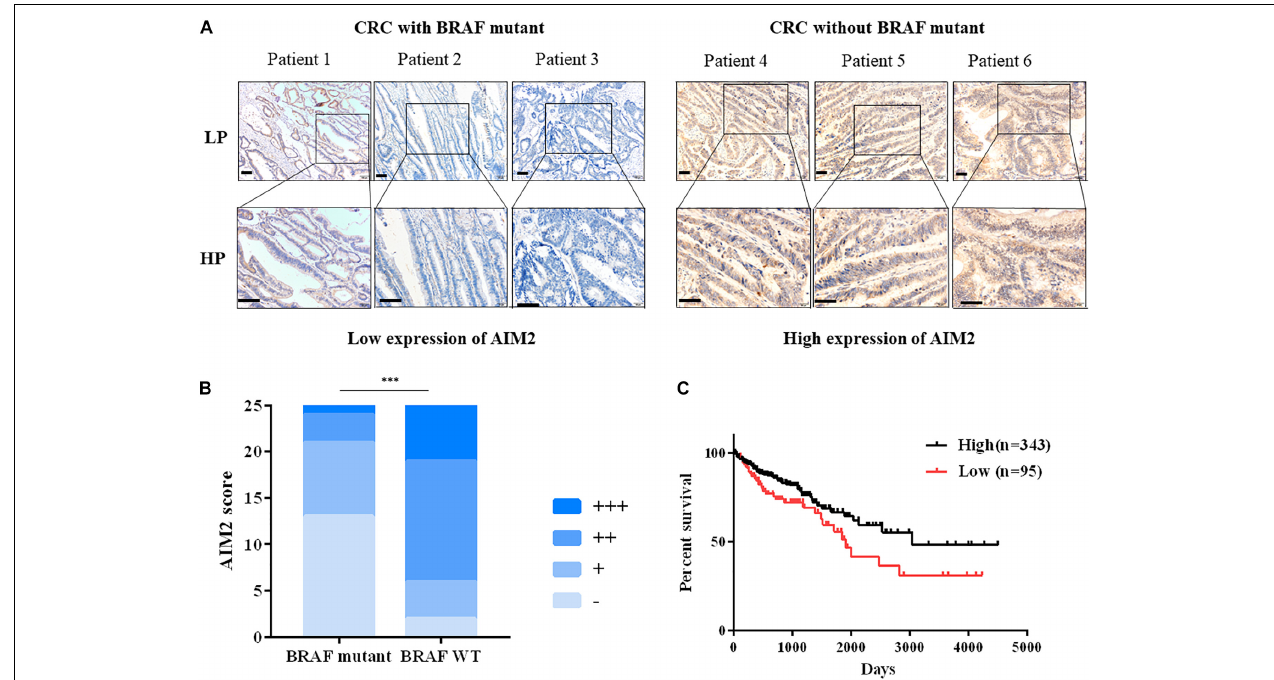
FIGURE 1 | Decreased AIM2 expression in BRAF-mutant CRC tissues. (A) Representative immunohistochemical staining of AIM2 in CRC tumor tissues with or without BRAF mutation. Scale bar: 100 µ m. (B) The quantitative scoring result of AIM2 IHC staining ( χ 2 test, p = 0.0002). (C) The correlation between AIM2 and CRC prognosis in TCGA cohort [log-rank (Mantel-Cox) test, p = 0.02]. ∗ p < 0.05, ∗∗ p < 0.01, ∗∗∗ p < 0.001.